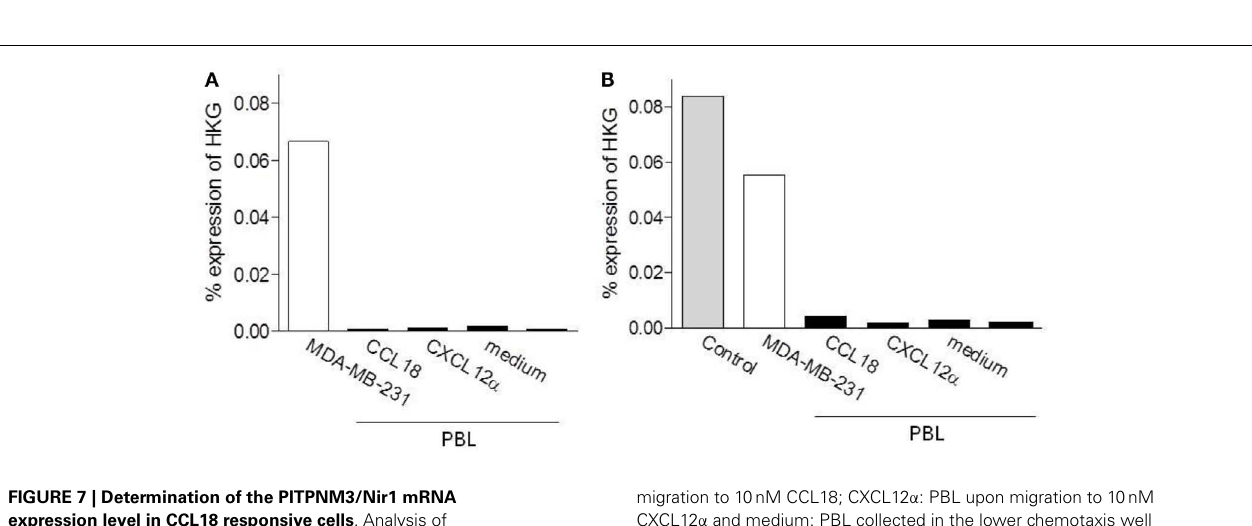
FIGURE 6 | Evasin-1 neutralizes the antagonistic effect of CCL18 on CCR3 . (A) Equilibrium competition binding assay of 125 I-CCL18 on L1.2/CCR3 transfectants using an increasing concentration of CCL11 and the CCL18-binding proteins Evasin-1, -3, and -4. Data are expressed in cpm ± SEM. Data points are in triplicate. Inhibitory activity of CCL11 (IC 50 : 4.99nM), Evasin-1 (IC 50 : 7.94nM), and -4 (IC 50 : 0.03nM) on 125 I-CCL18 binding to CCR3. (B) Inhibition of chemotaxis using L1.2/CCR3 transfectants.